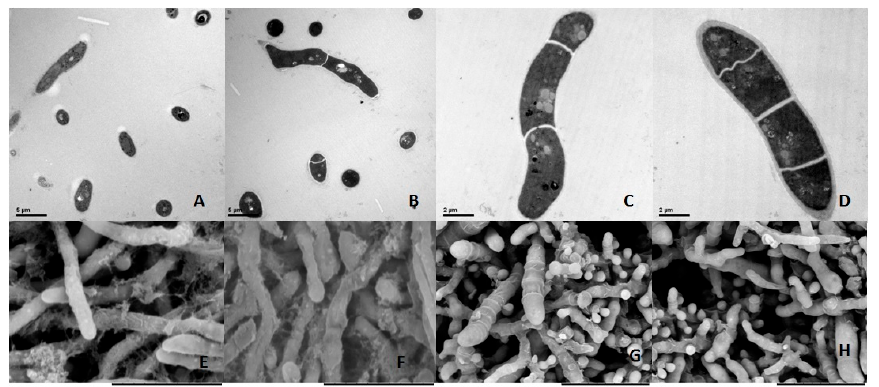
Figure 2. Ultra-structure of fungi submitted to various treatments. ( A , E ): 1 mg/mL berberine, ( B , F ): 0.5 µ g/mL Clotrimazole, ( C , G ): Control group was treated with DMSO, ( D , H ): Negative group untreated infected cells. ( A – D ): Transmission electron microscopy (TEM); ( D – G ): Scanning electron microscopy (SEM). T. mentagrophytes significantly shrunk after treatment with berberine or clotrimazole as assessed